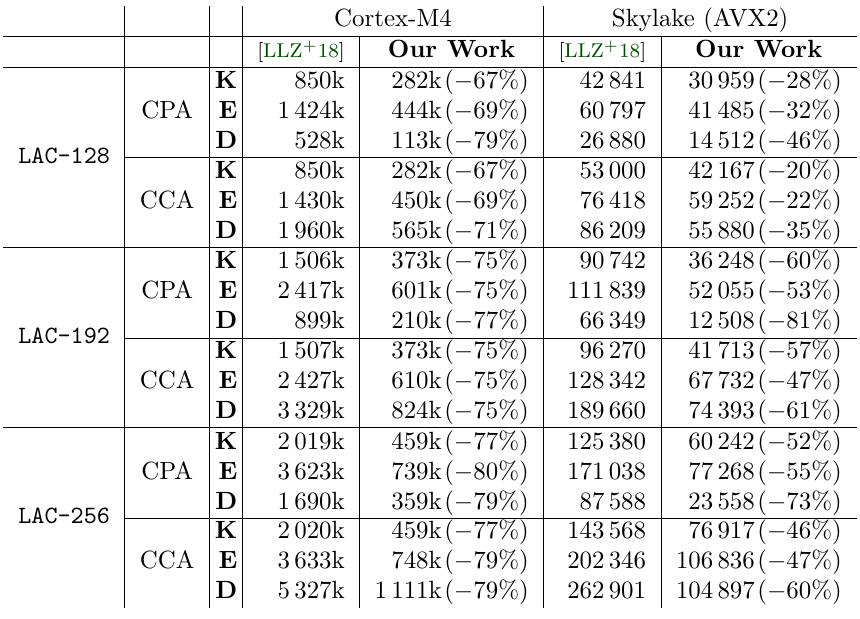
Table 10: Performance results in clock cycles for LAC Cortex-M4 Our Work Our